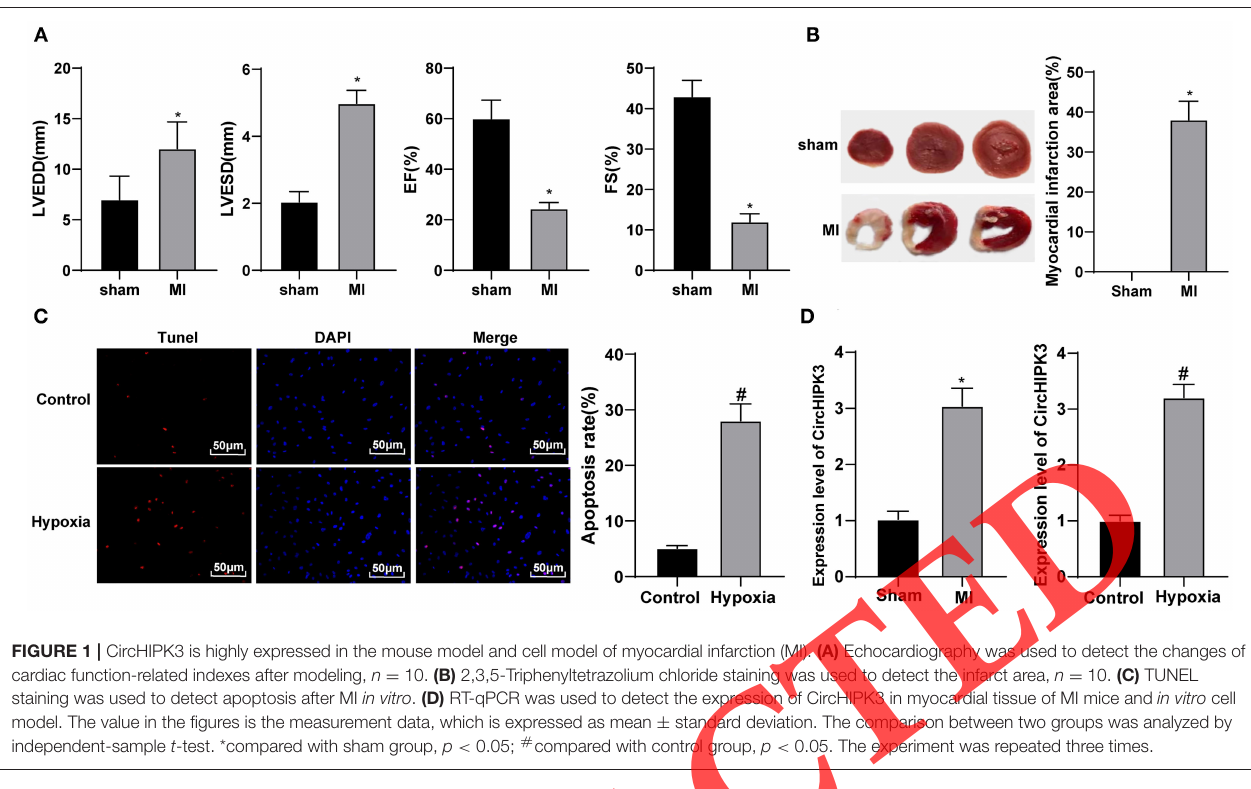
cytoplasm ( Figure 3A ). Through the Starbase website (http://